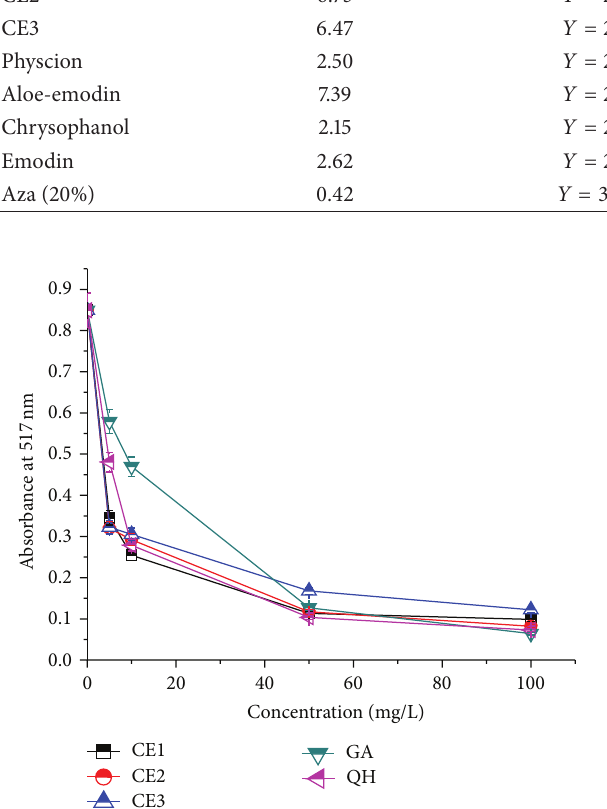
Figure 5: Free radical scavenging activity of the extracts of Rheum emodi and standard